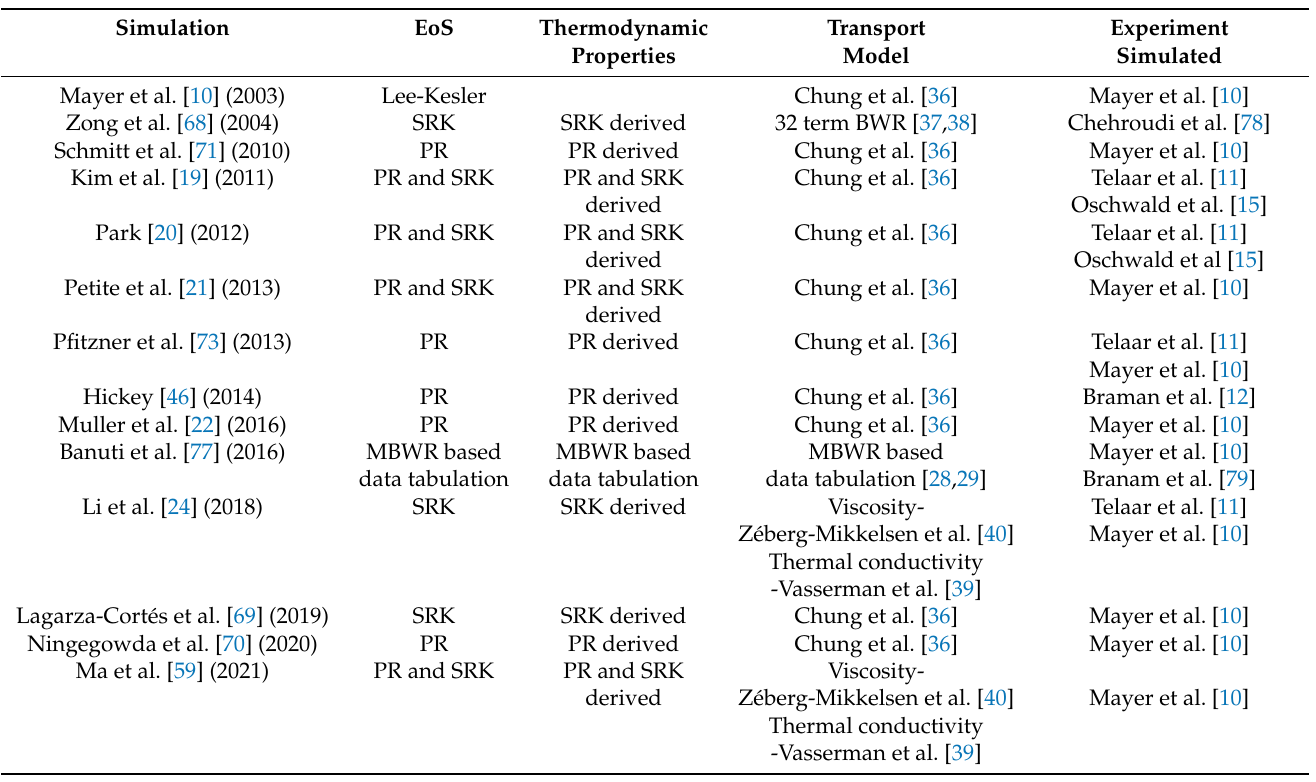
Table 3. Table summarising the EoS and thermo-physical models used in some past numerical simulation of cryogenic fluids. The last column refers to the experiments against which the predicted behaviour of the cryogenic jets is